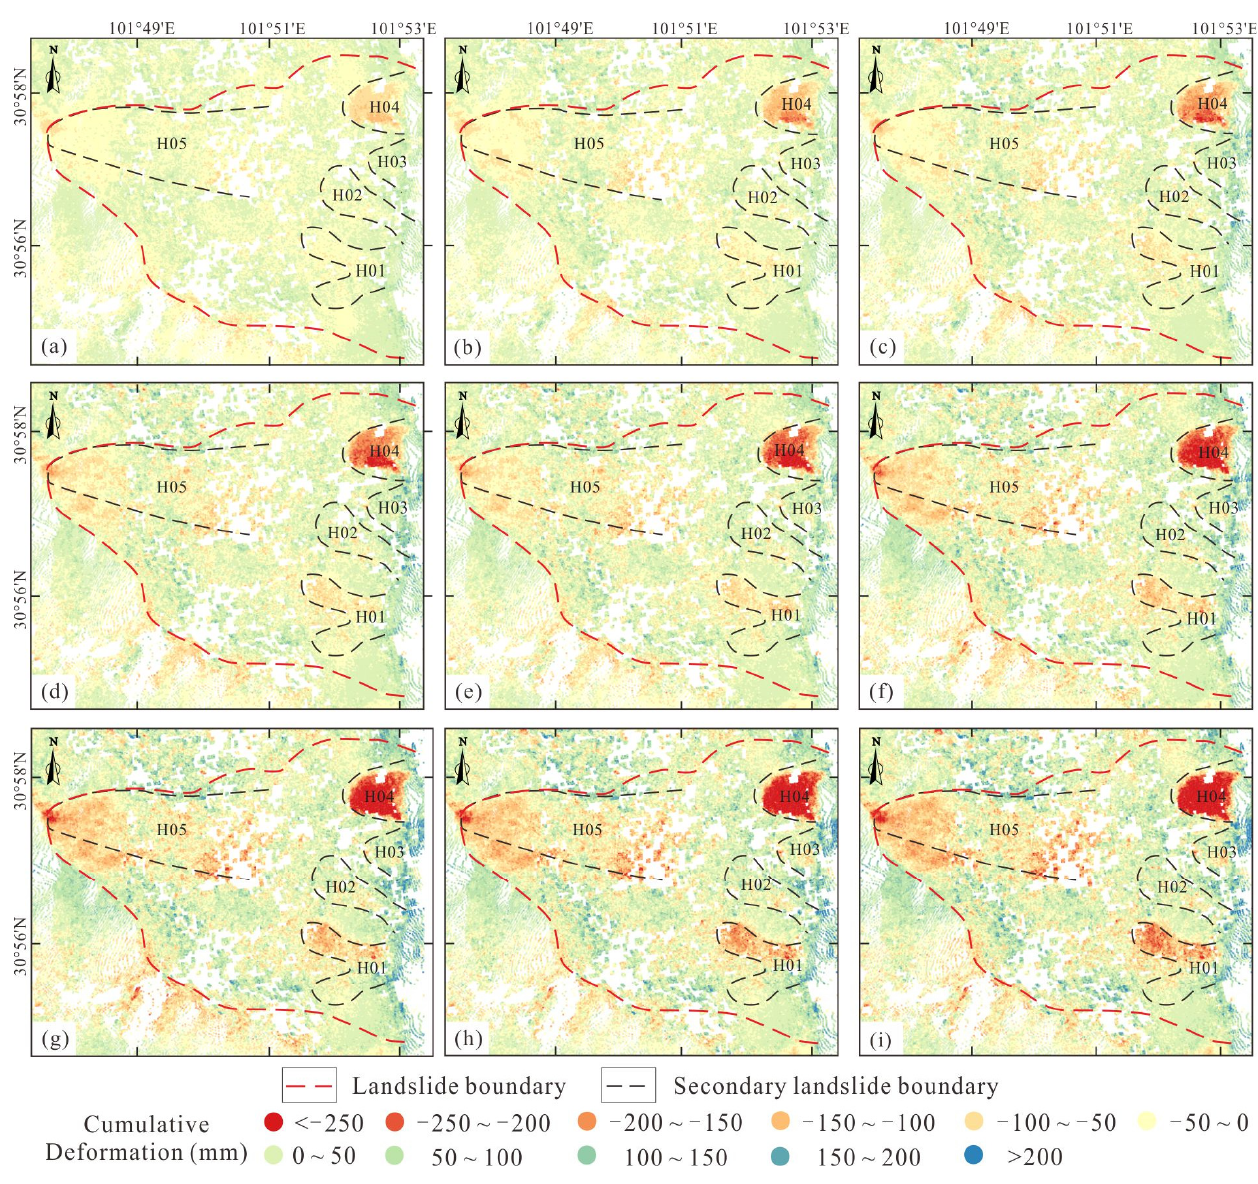
Figure 10. Cumulative deformation at different times calculated by InSAR (LOS); ( a ) 19